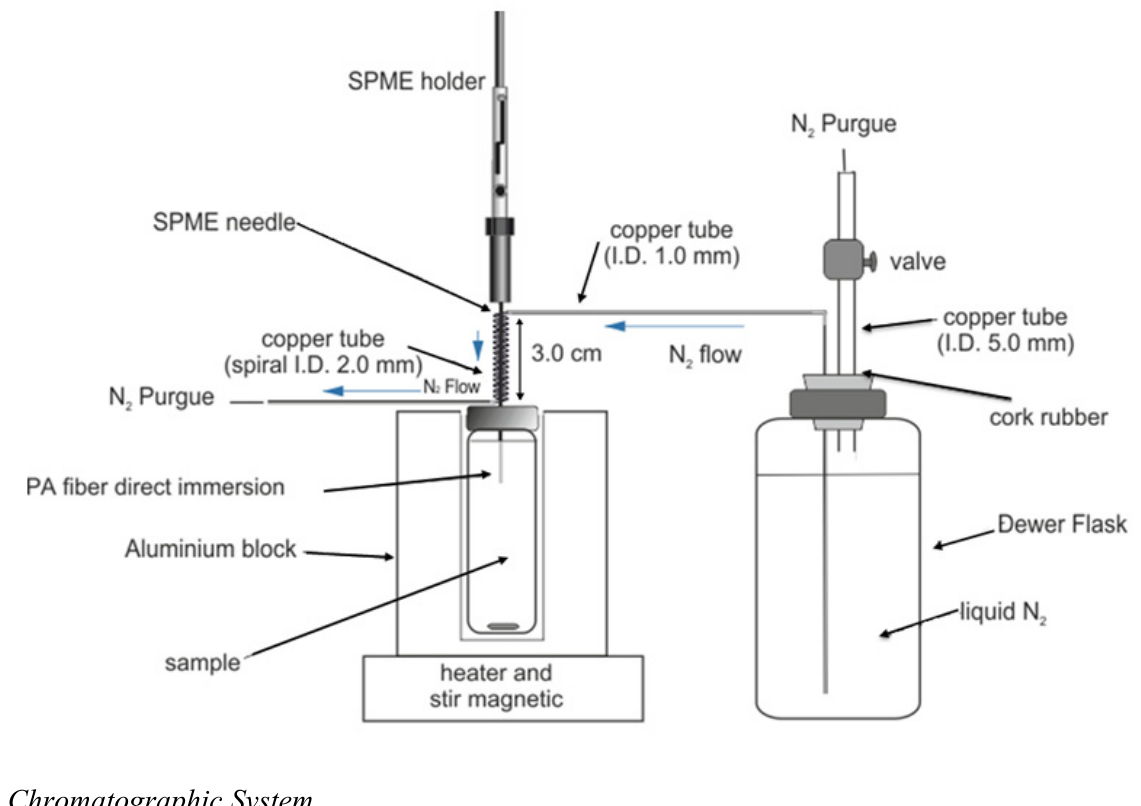
Figure 1. Schematic of the CF-SPME